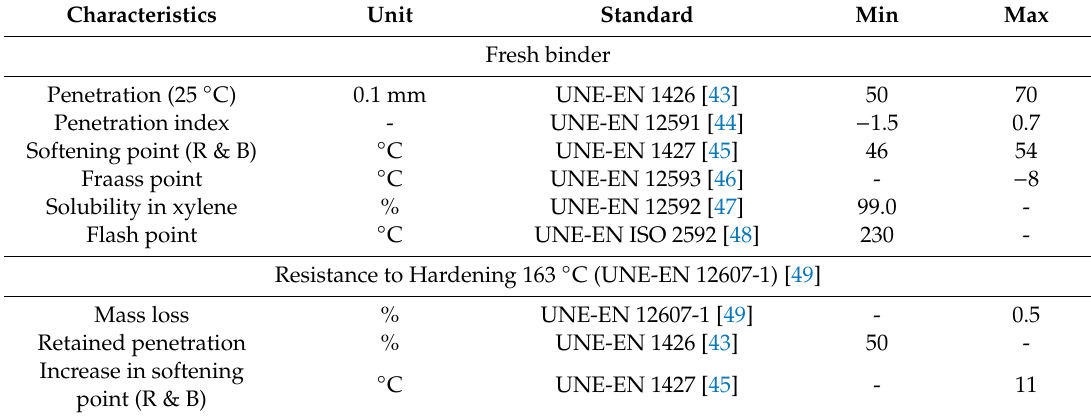
Table 1. Technical specifications of the bitumen